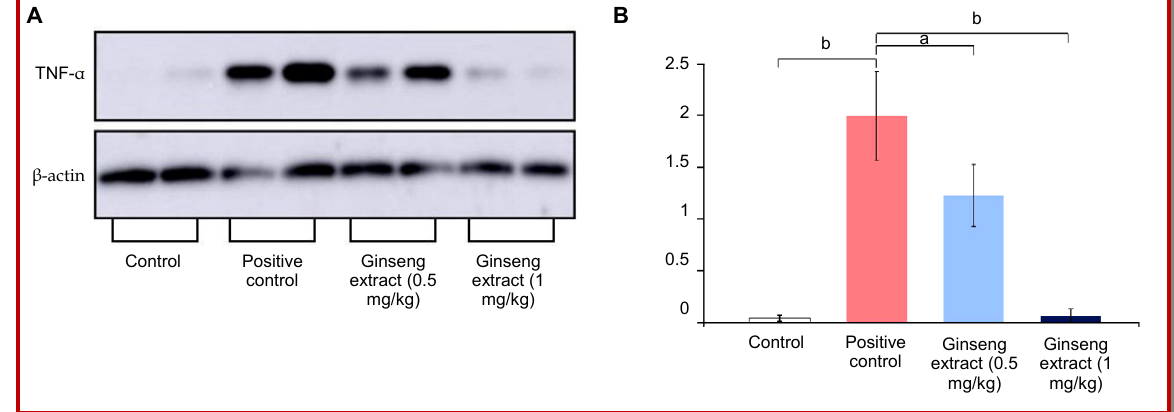
Figure 5: Effect of ginseng extract on TNF- α expression in cornea tissue of benzalkonium chloride-induced dry eye syndrome mouse. (A) Western-blot analysis for TNF- α. ( B) The expression of TNF- α was gauaged by normalization based on β -actin intensi- ty as shown in (A). The expression value of the control was set to 1.0. (n = 4, a p<0.05, b